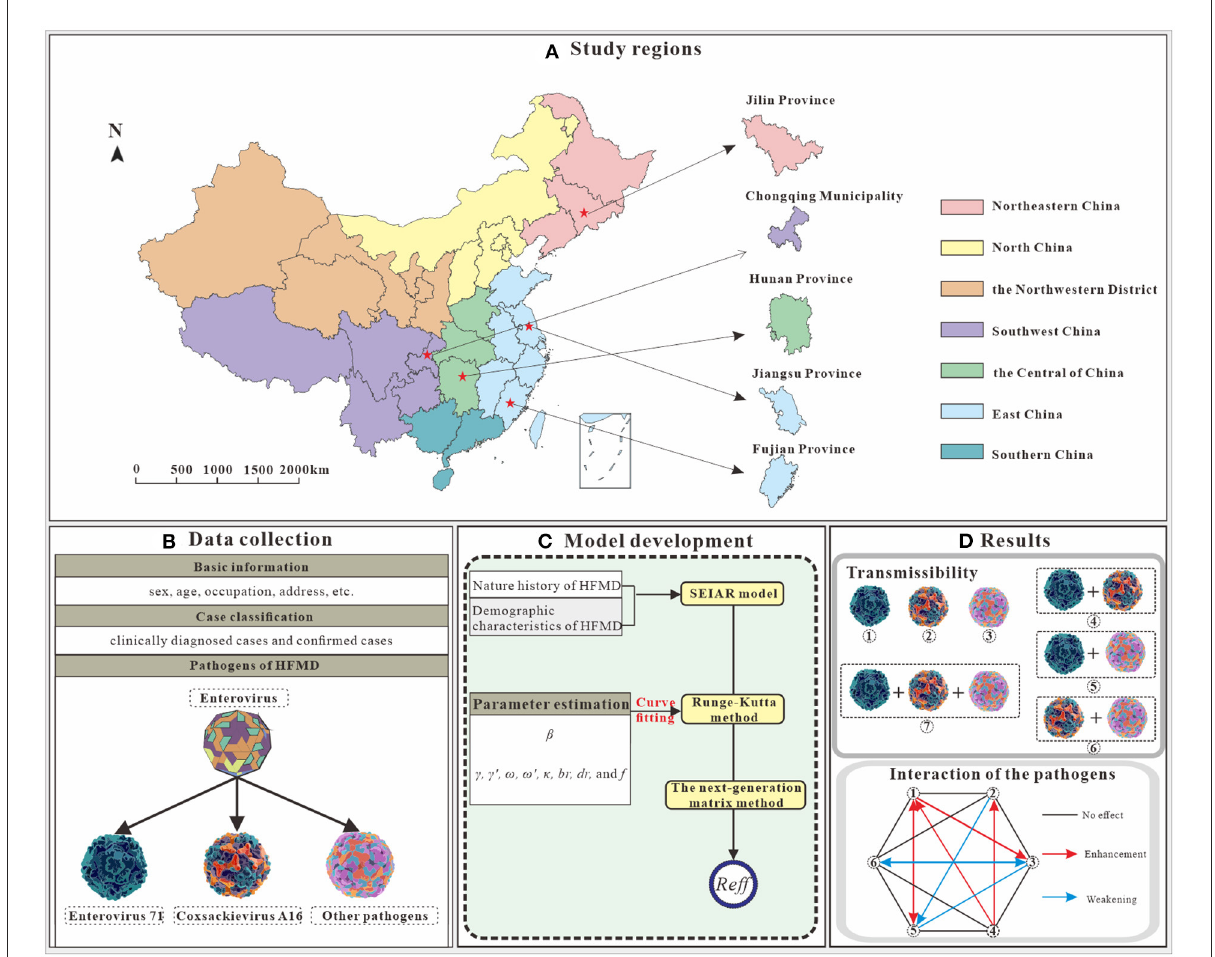
FIGURE1 Study design on interaction study of major pathogens of HFMD [ (A) We selected five study areas from four administrative regions. (B) Collection of basic information, HFMD incidence and pathogen data. (C) A SEIAR model was constructed based on the natural history of HFMD, and incidence rate of HFMD were fitted. (D) Clues to pathogen interactions were obtained by comparing the R eff in seven scenarios. Illustrations from https://www.dreamstime.com/stock-illustration-enterovirus-which-causes-hand-foot-mouth-disease-hfmd-colorful-background-d- illustration-model-built-using-data-image81638134, EV-A71; https://www.dreamstime.com/stock-illustration-coxsackievirus-virus-which- causes-respiratory-enteric-brain-infections-enterovirus-isolated-white-background-d-image82681501, CV-A16; https://www.dreamstime. com/stock-illustration-enterovirus-d-which-causes-respiratory-infections-children-isolated-white-background-illustration-model-built- using-image81605888, other